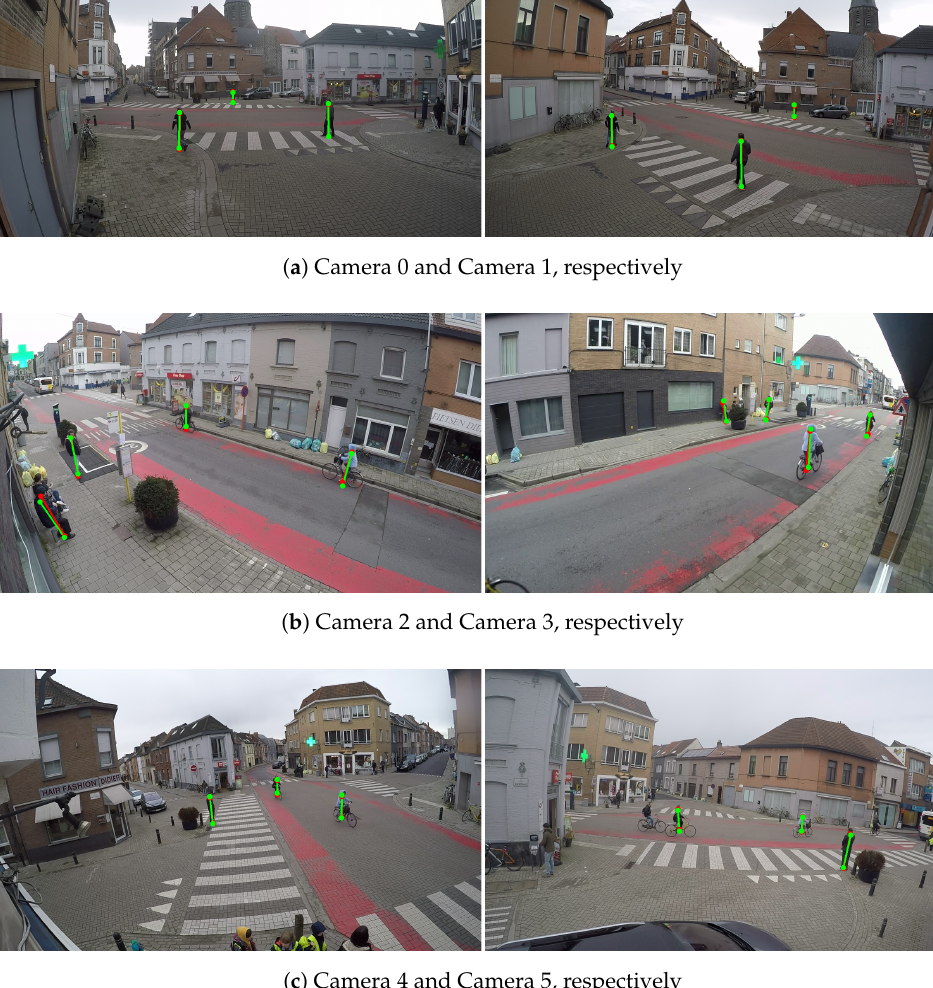
Figure 9. Example of detected the bottom and top positions of the pedestrians of Camera network 5—multiple pedestrians at an intersection. Red color represents detected positions by the human pose estimation method. Green color represents the detected reprojected